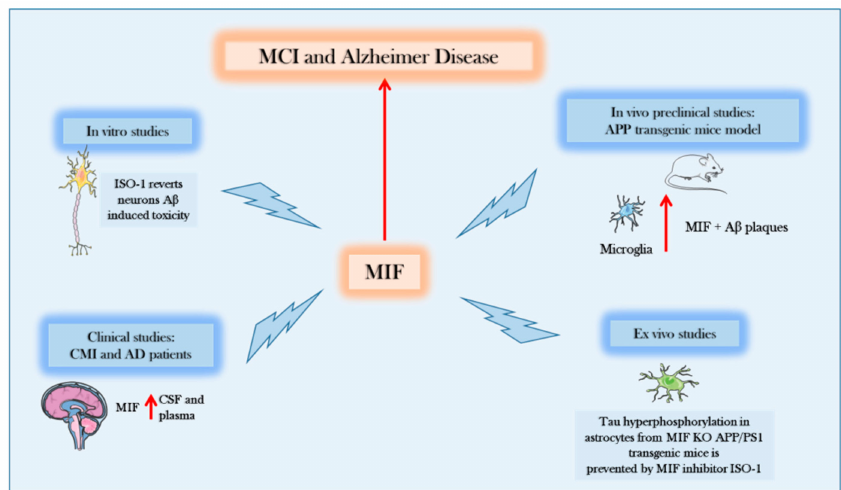
Figure2. EvidencessupportingtheroleofMacrophageMigrationInhibitoryFactor(MIF)inAlzheimer (cid:48) s disease (AD). In-vitro, in-vivo, and ex-vivo preclinical data, as well as data from AD and MCI patients show that MIF is increased during the course of the disease and that therapeutic intervention aimed at counteracting MIF function may exert beneficial e ff ects on AD course. MCI: Mild Cognitive Impairment; Ab: Amyloid Beta; APP: Amyloid Precursor Protein; PS1: Presenilin 1; CSF: CerebroSpinal fluid;